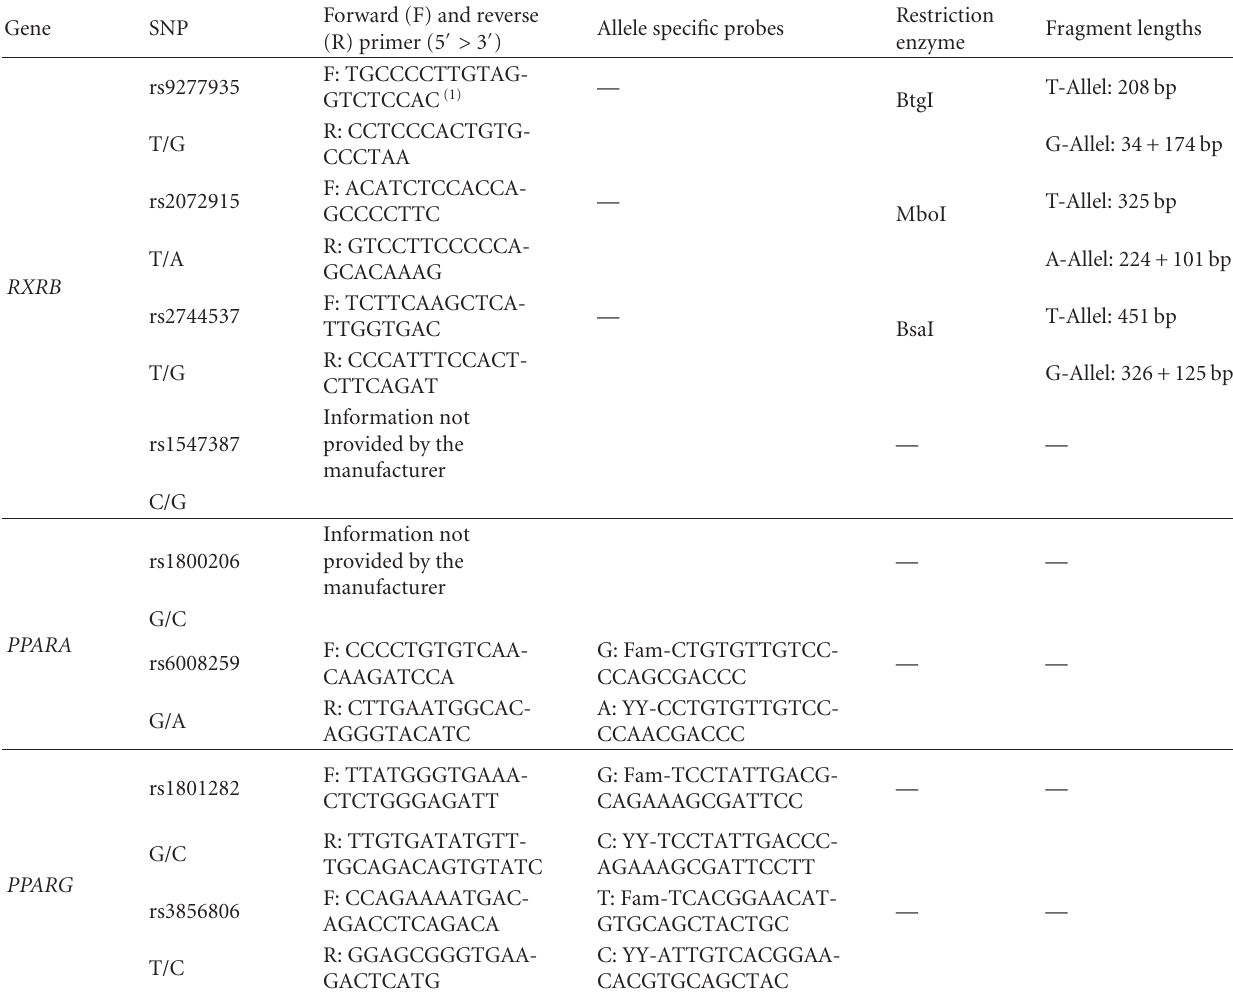
Table 1: Oligonucleotides and restriction enzymes used for